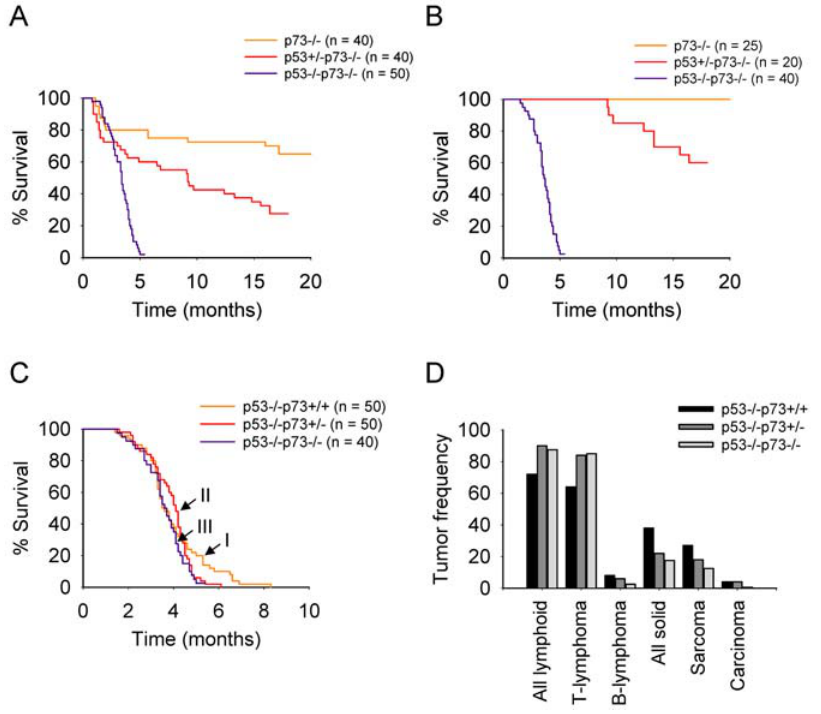
Figure 1. Mice deficient for p53 and p73 are highly prone to T cell lymphomas. A, B. Kaplan-Meier curves of overall ( A ) and tumor-free survival ( B ) of p73 2 / 2 , p53 + / 2 p73 + / 2 and p53 2 / 2 p73 2 / 2 mice. The number of mice of each genotype is indicated. C. Kaplan-Meier curves of tumor-free survival of p53 2 / 2 , p53 2 / 2 p73 + / 2 and p53 2 / 2 p73 2 / 2 mice. D. Tumor spectra in mice of the indicated genotypes.